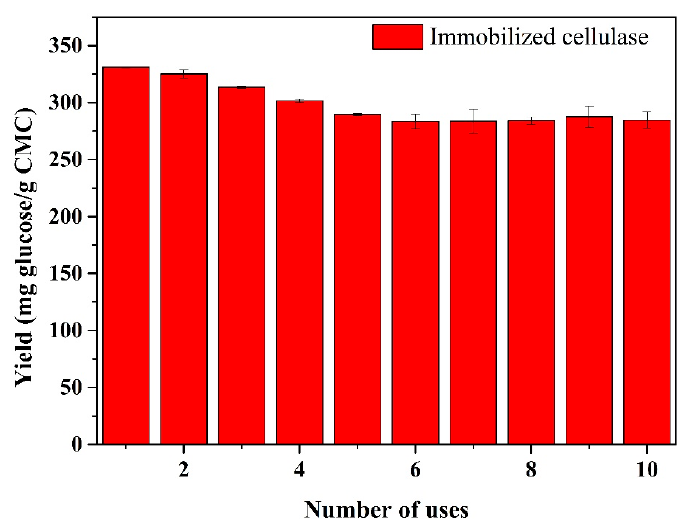
Figure 10. Effect of recycling on the glucose productivity of immobilized cellulase. Each cycle was performed at pH 4 and 60 °C for 24 h.